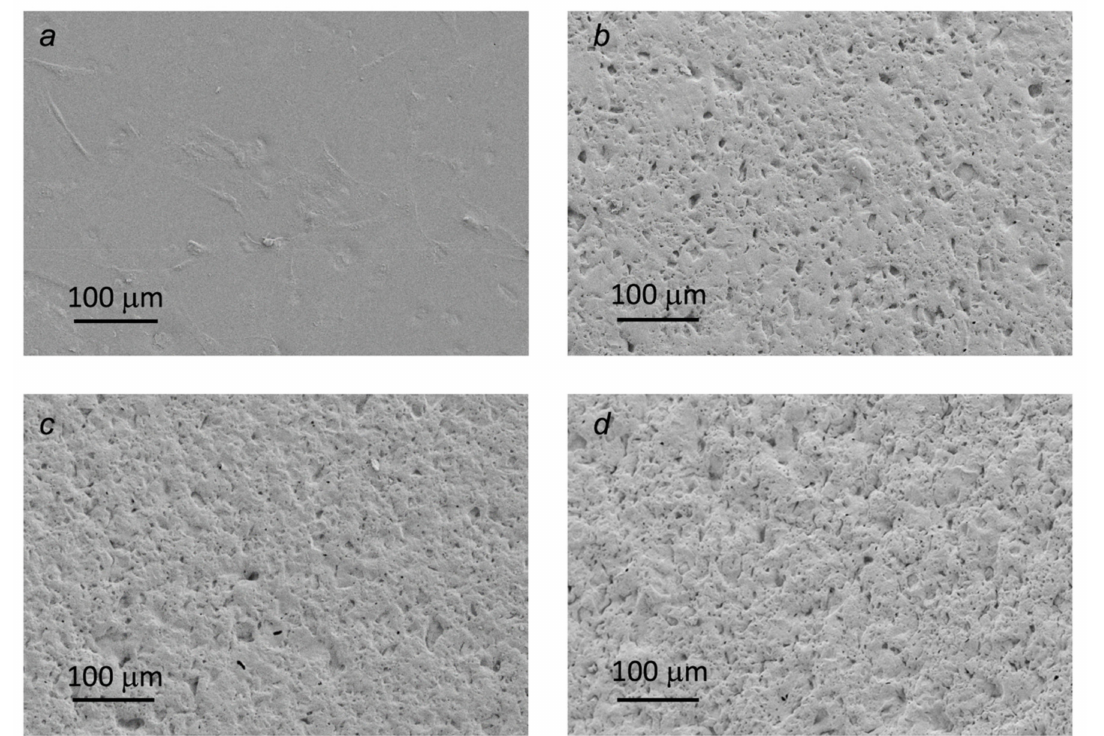
Figure 4. SEM micrographs of the pure chitosan film ( a ); composite films containing 10% ( b ), 20% ( c ), and 30% of lignin ( d